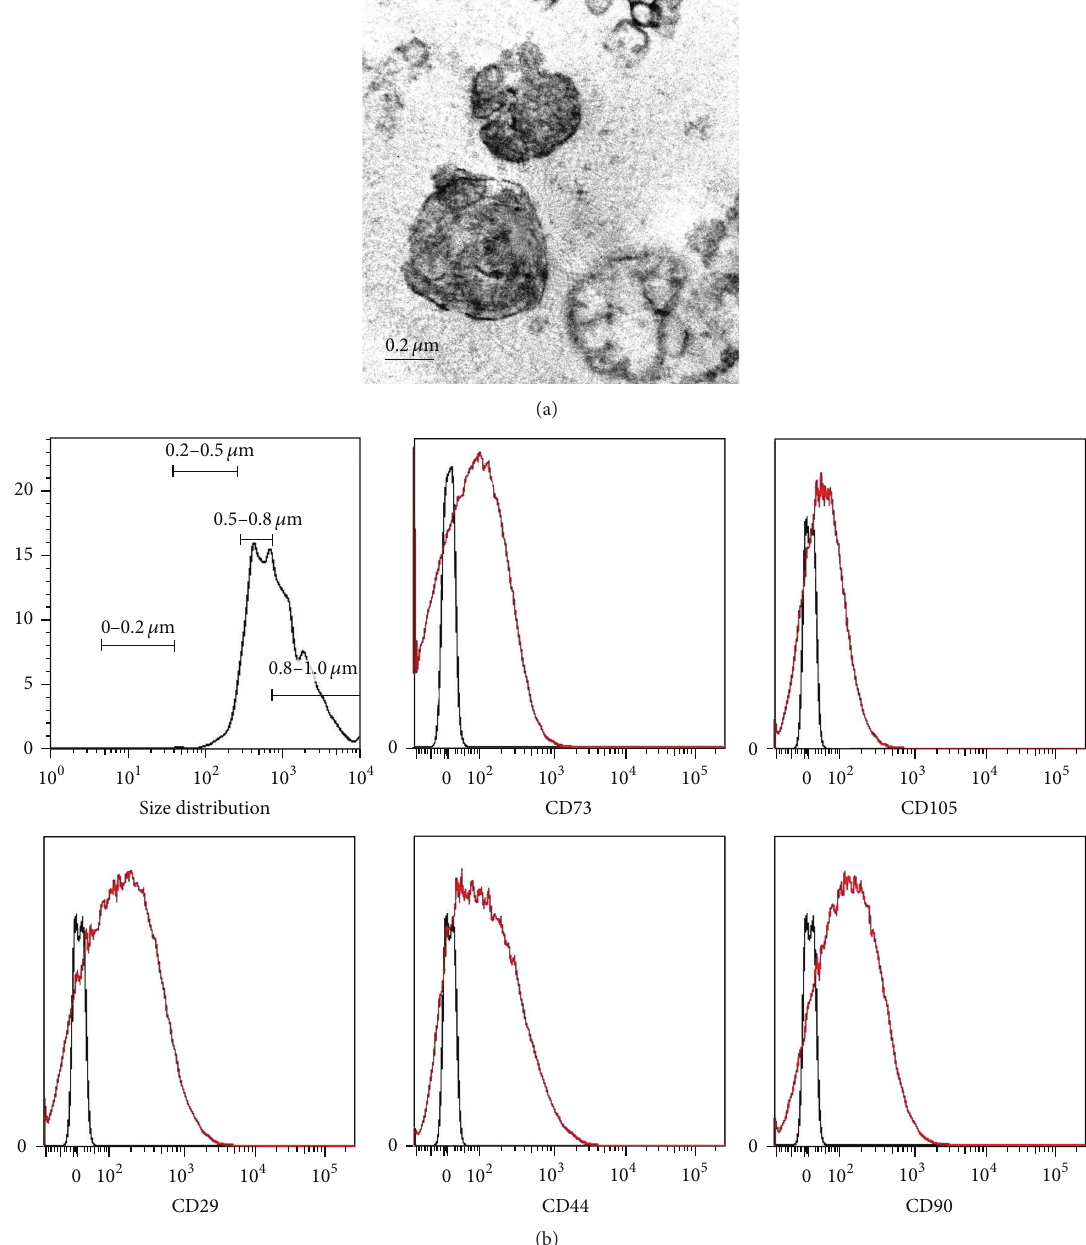
Figure 1: Characterization of MSC-MVs. (a) Typical morphology of MSC-MVs observed under a transmission electron microscope. Scale bar = 0.2 𝜇 m. (b) Representative flow cytometric histograms of MV surface marker